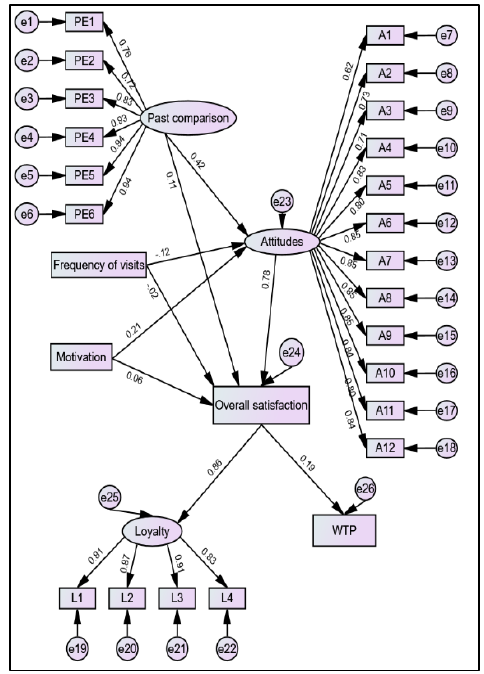
Figure 9. SEM for tourists.